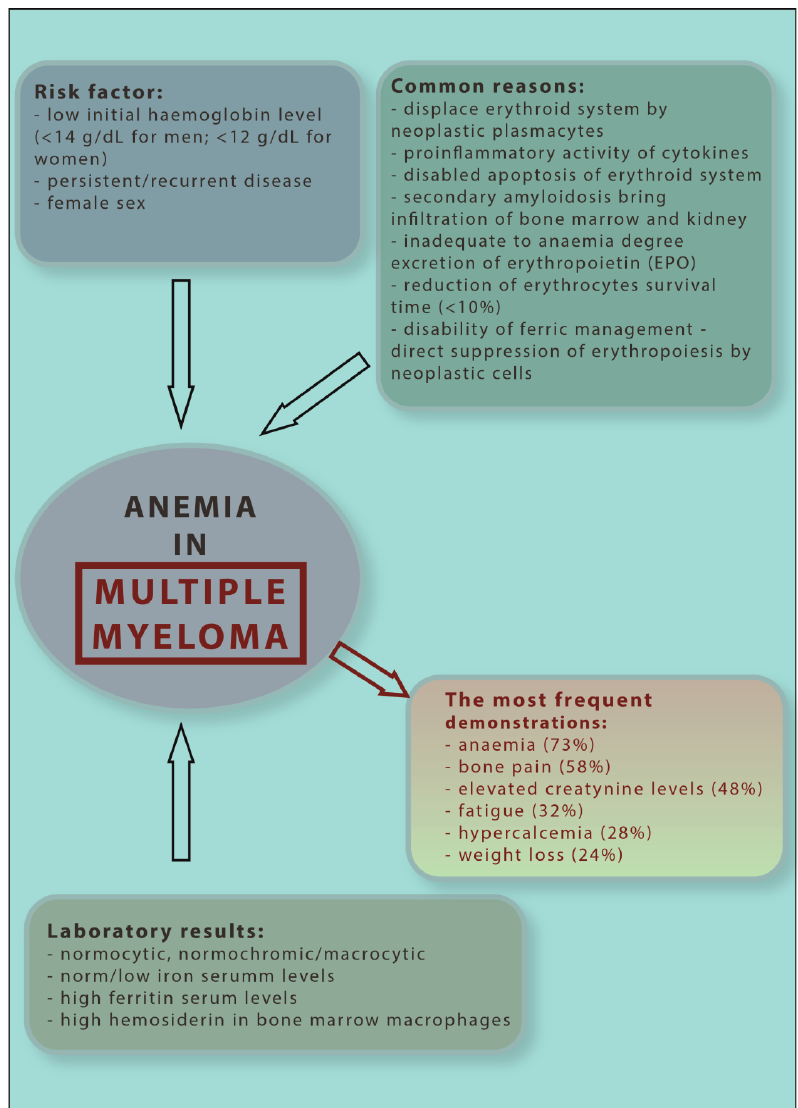
Figure 2. Diagnostic and clinical scheme of multiple myeloma anaemia.